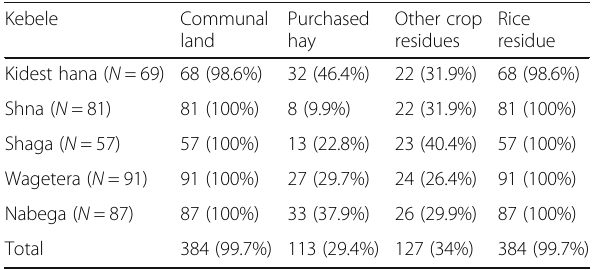
Source: surveyed data directly collected from sample household in